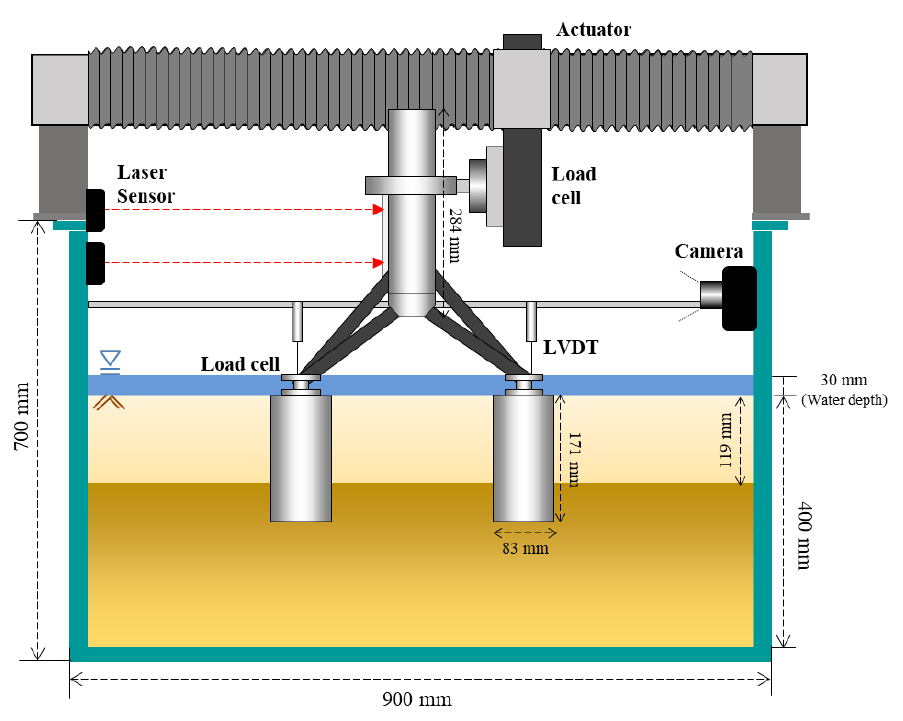
Figure 7. Centrifuge testing setup for cyclic loading experiment.